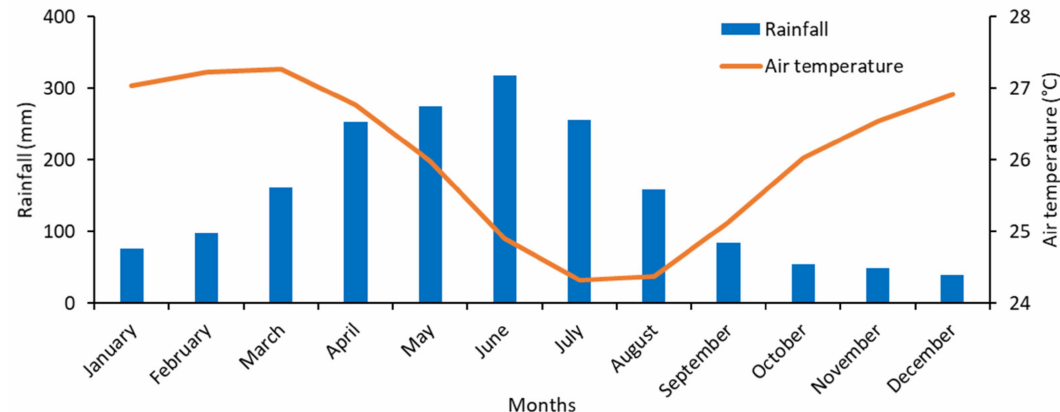
Figure 2. Annual distribution of the mean temperature and rainfall of the ECNEB for the monthly historical series from 1981 to